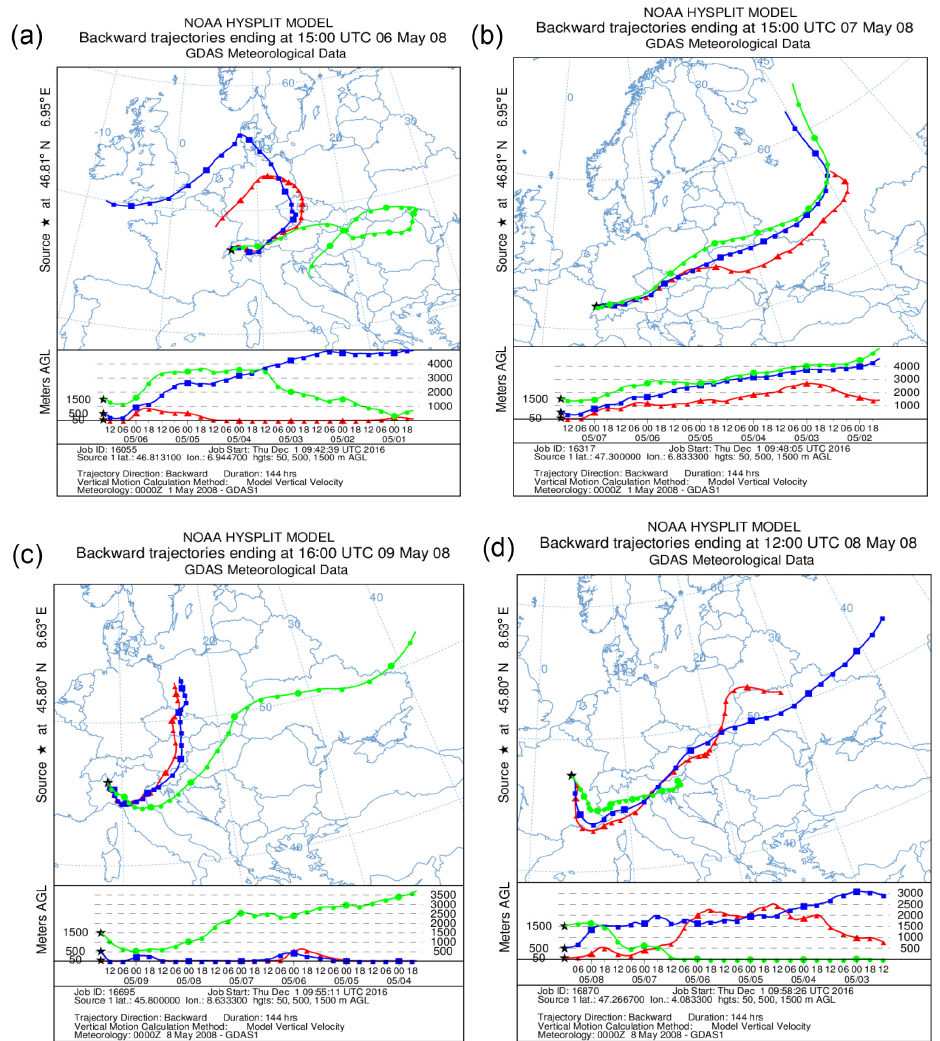
Figure 11. Backward trajectories during the 6–9 May 2008 ozone episode ending at EMEP rural ozone stations in Switzerland and Italy (left column), and in France (right